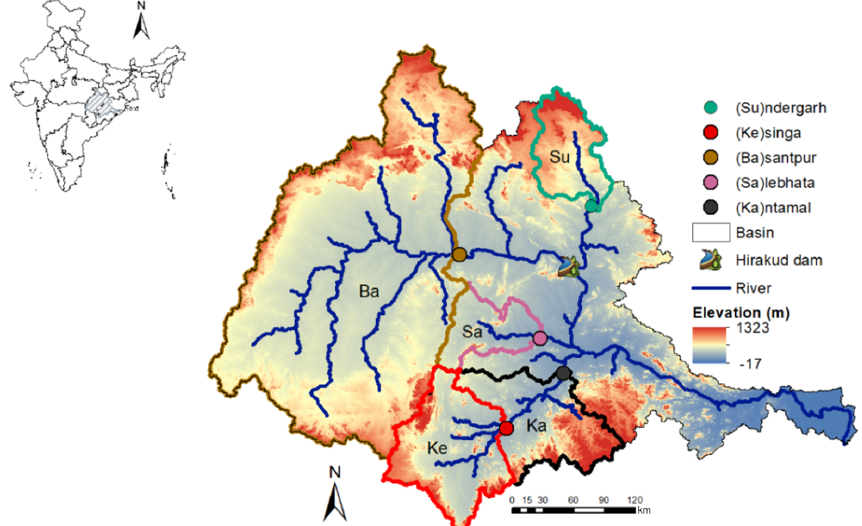
Figure 1. The Mahanadi river basin boundary and the analysed flow gauges and their catchments. Abbreviations for catchment names are Ba – Basantpur, Ka – Kantamal, Ke – Kesinga, Su – Sundergarh and Sa – Salebhata.